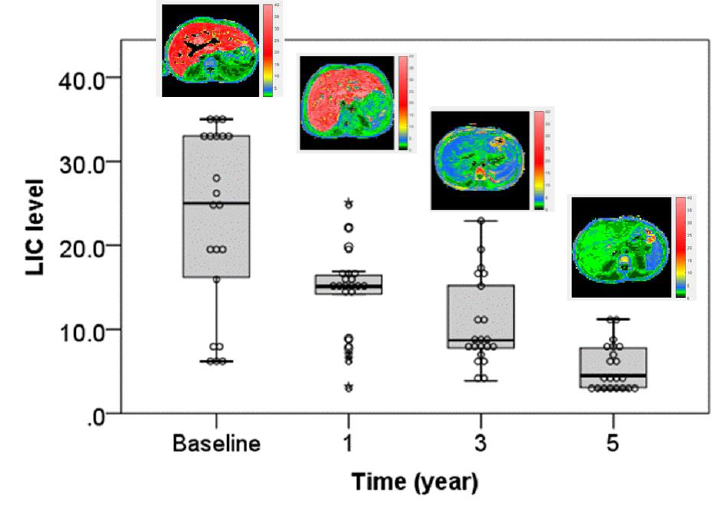
Figure 1. Significant improvement and increased cardiac T2* value (msec) at baseline, one year, three Tomography 2021 , 7 , FOR PEER REVIEW Figure 1 . Significant improvement and increased cardiac T2 * value ( msec ) at baseline, one year, years, and five years. three years, and five years .